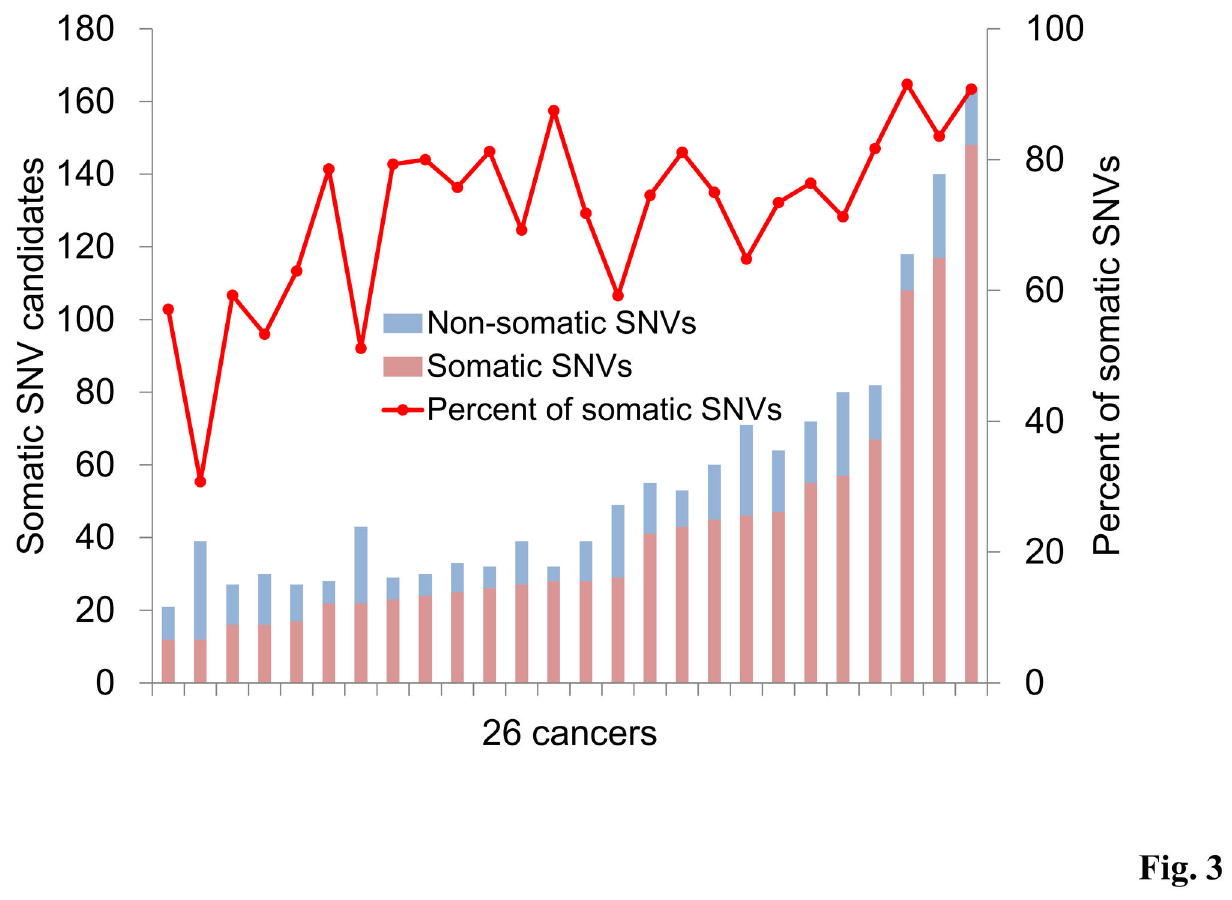
Figure 3. Fidelity of the germline SNV detection in cancer exome analysis. Somatic SNV candidates were identified by using 26 cancer exomes and each normal counterpart. Correct somatic SNVs and false positives were shown in pink and blue bars, respectively. The 26 cancers used for the analysis were sorted by the increasing total number of SNVs (x-axis). doi: